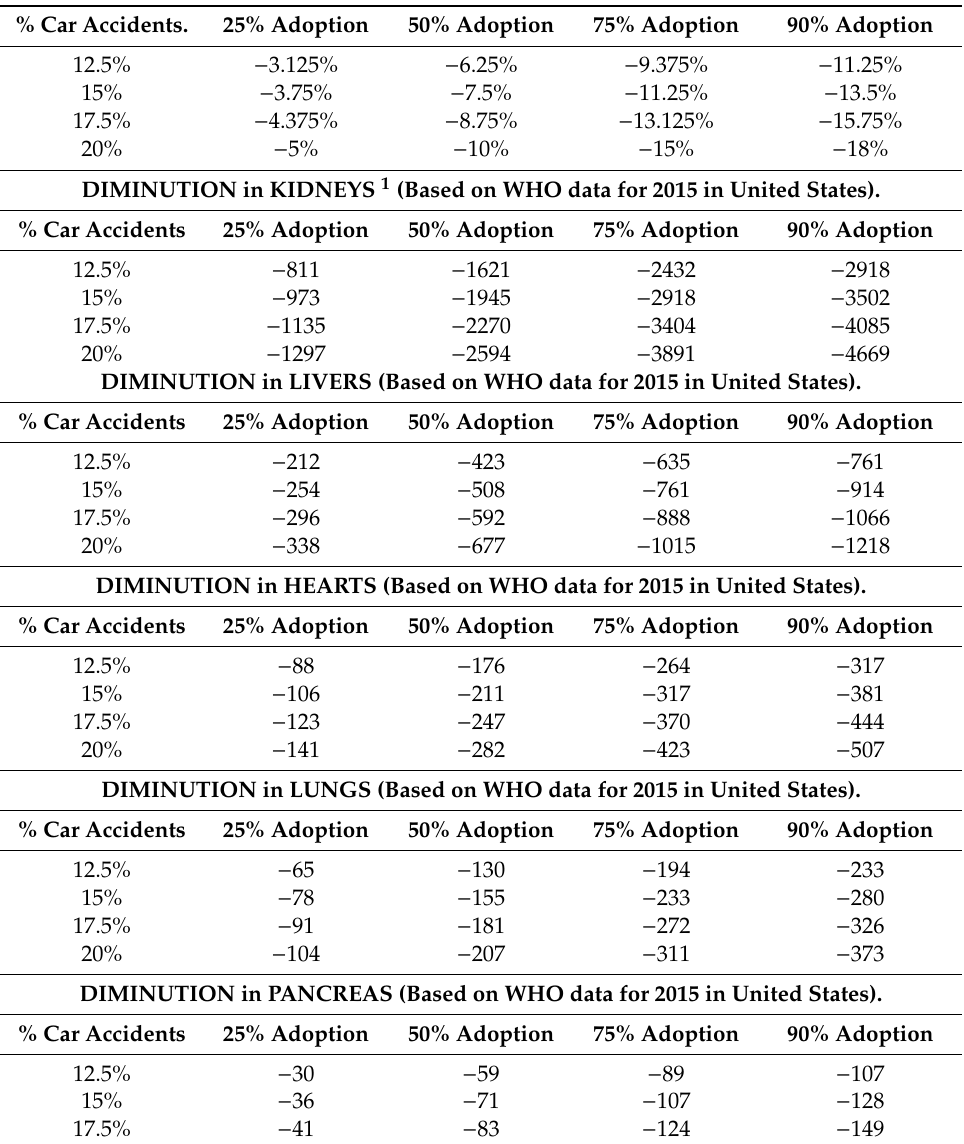
Table 2. Estimated decline in the supply of organs for transplant in the United States. % Car Accidents.